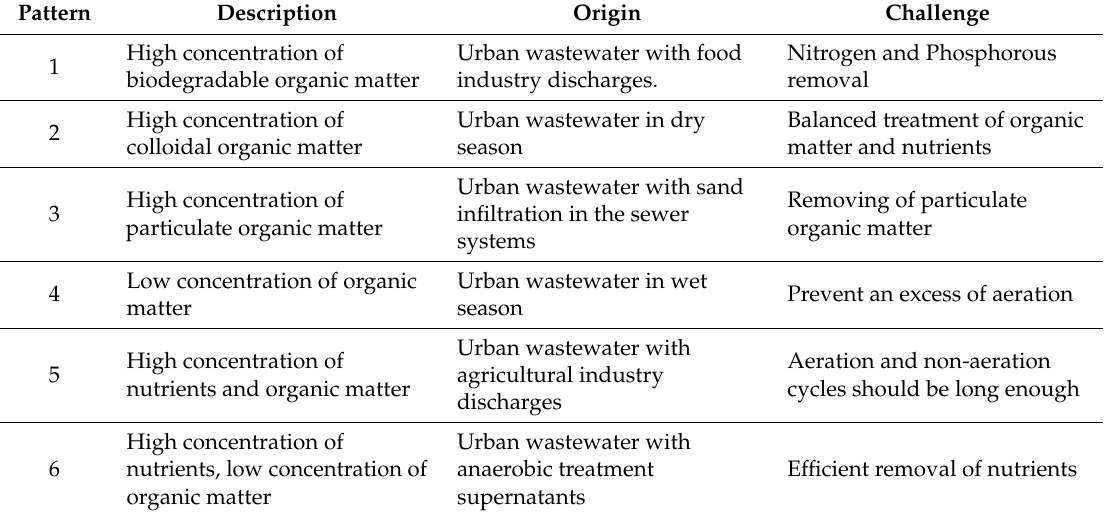
Table 1. Description of the six pollution patterns used to test the performance of the controllers.